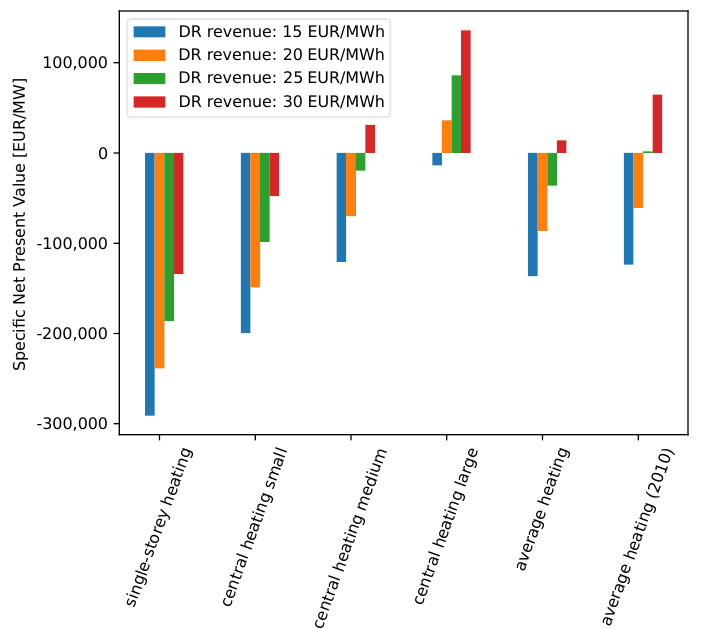
Figure 17. Influence of heat pump size classes and the weather year on the specific net present value for an exemplary grid node in the city of